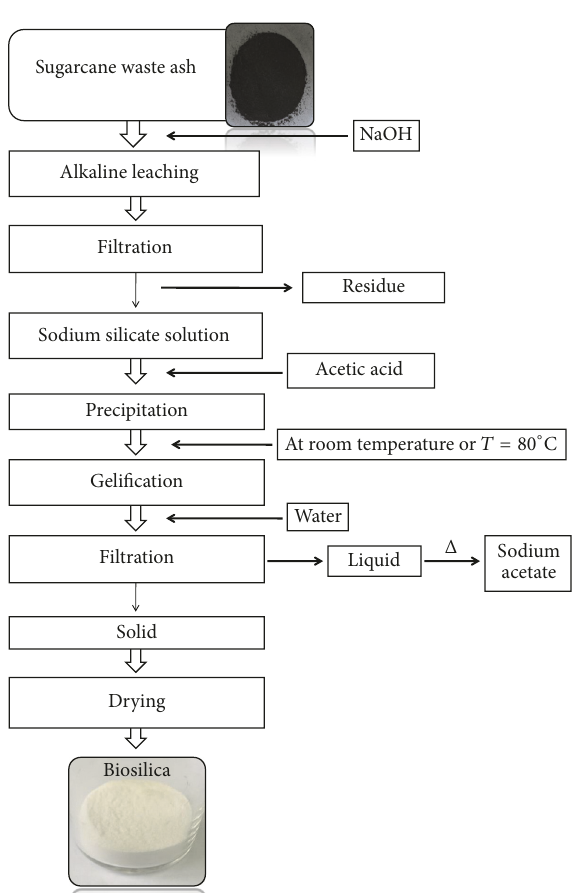
Figure 1: Flow diagram of the procedure used to produce biosilica from sugarcane biomass